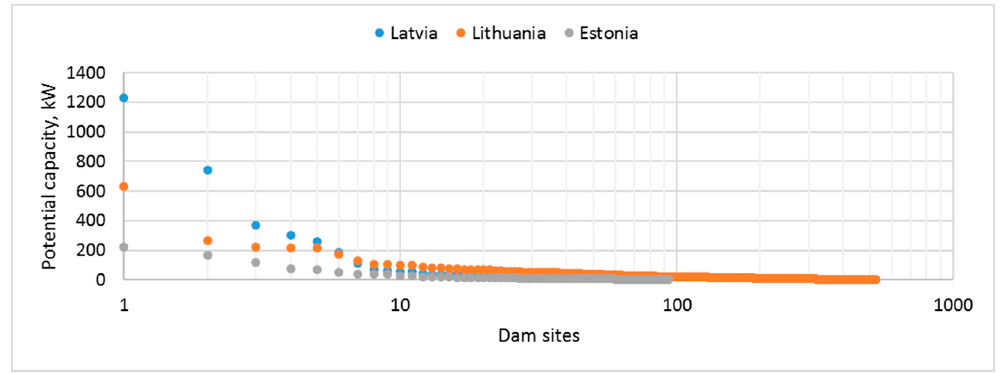
Figure 9. The potential capacity of existing dams in the Baltic States (note the logarithmic x